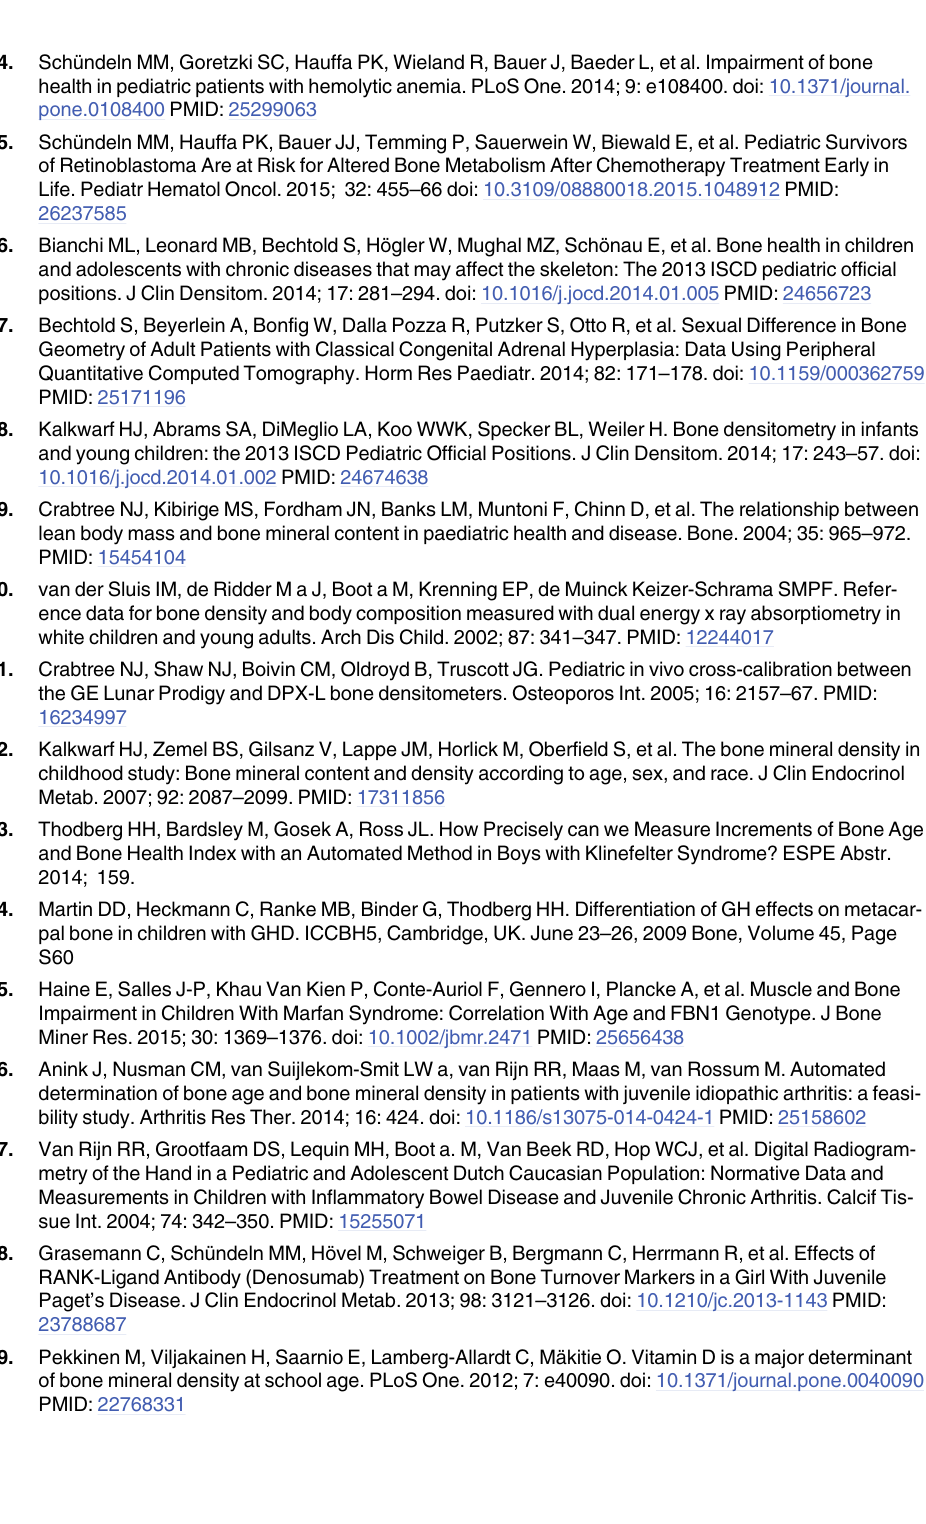
PLOS ONE | DOI:10.1371/journal.pone.0151936 March 25,